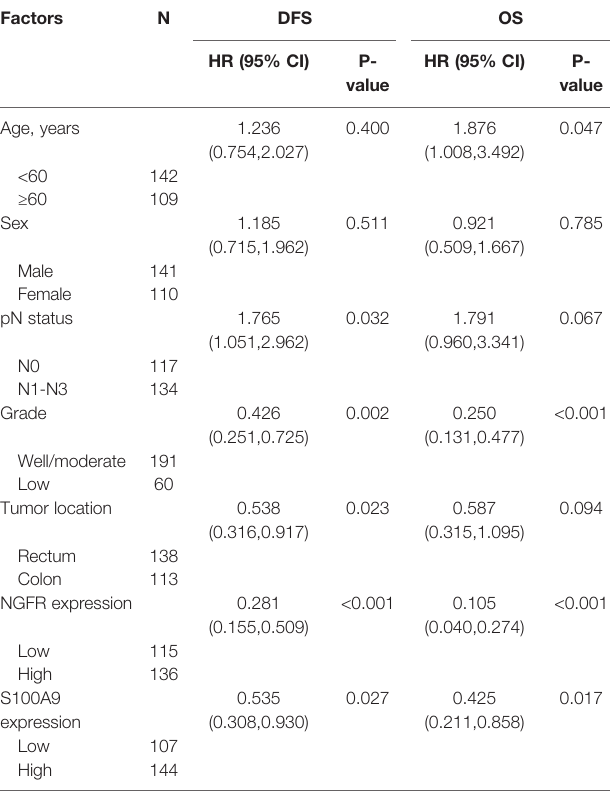
TABLE 2 | Multivariate analysis of disease-free survival and overall survival in 251 CRC patients.